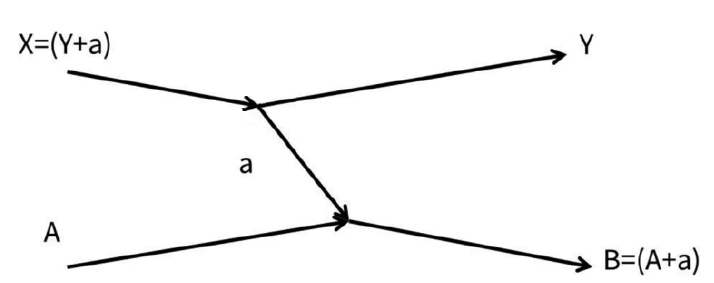
Figure 2. Sketch of a typical transfer reaction used to measure the ANC: The transferred particle a can usually be a proton, a neutron or a α